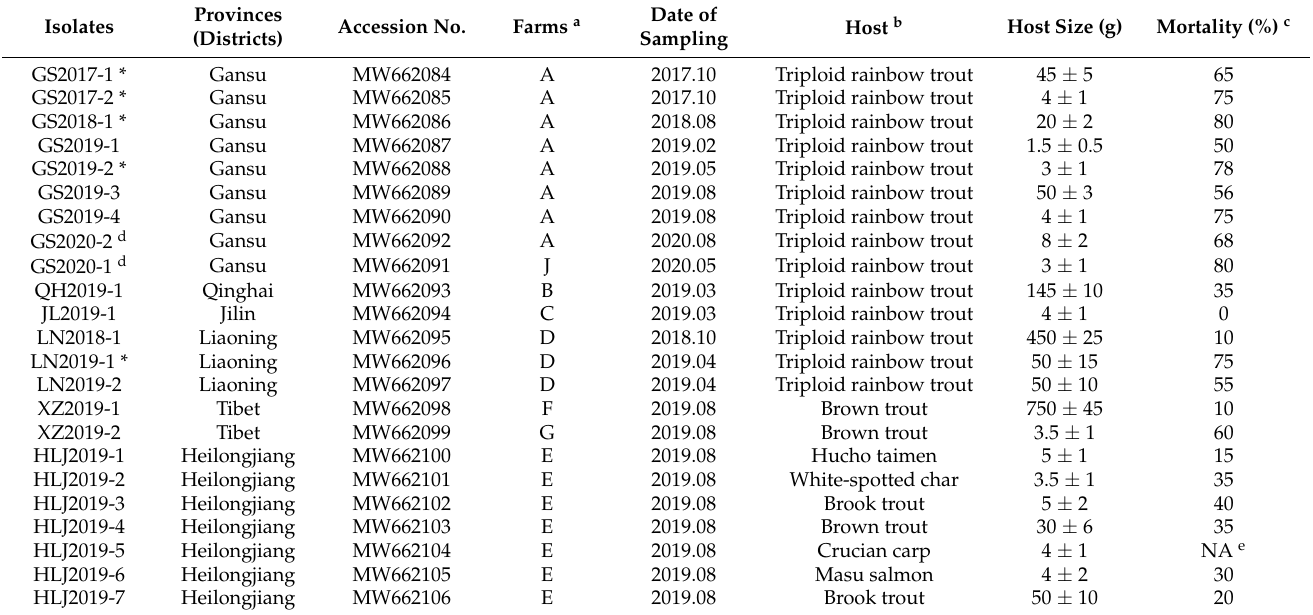
Table 3. The Chinese IPNV isolates used in this